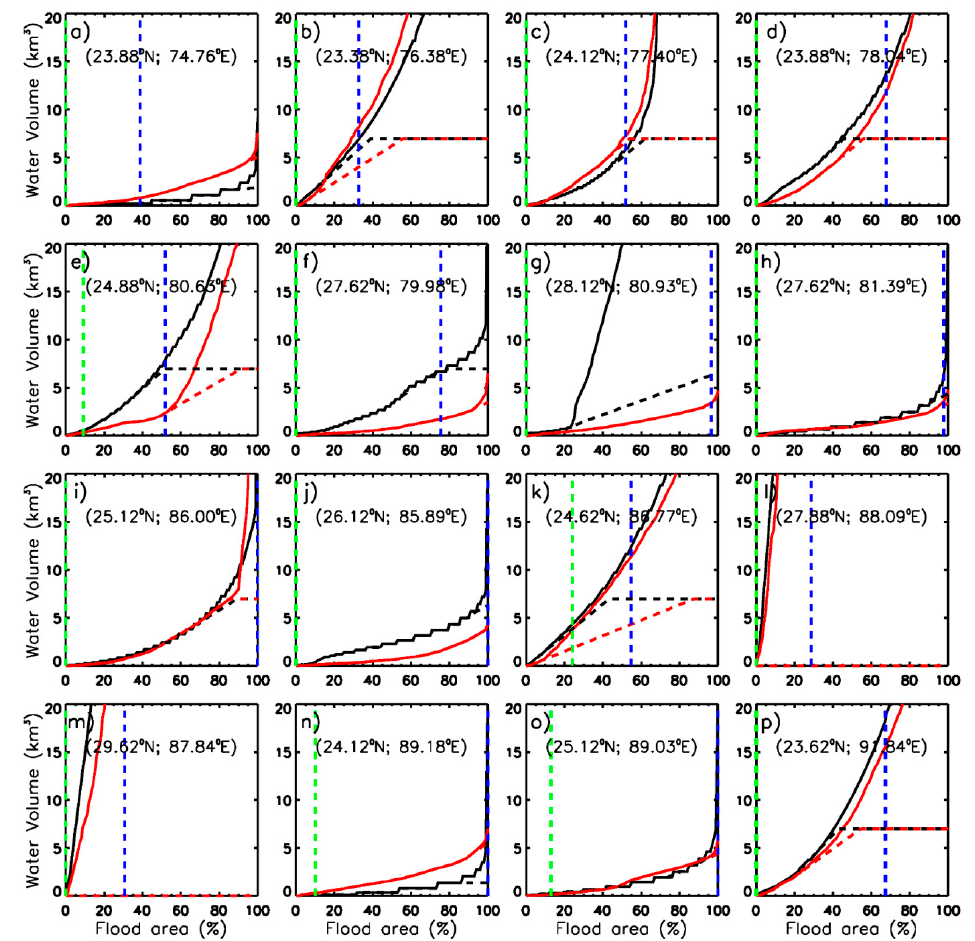
fixed at 0.4 km 3 ) are carefully replaced by a fitter value of the surface water storage based on a simple linear regression analysis using the 10 previous water volume values of the hypsographic curve.